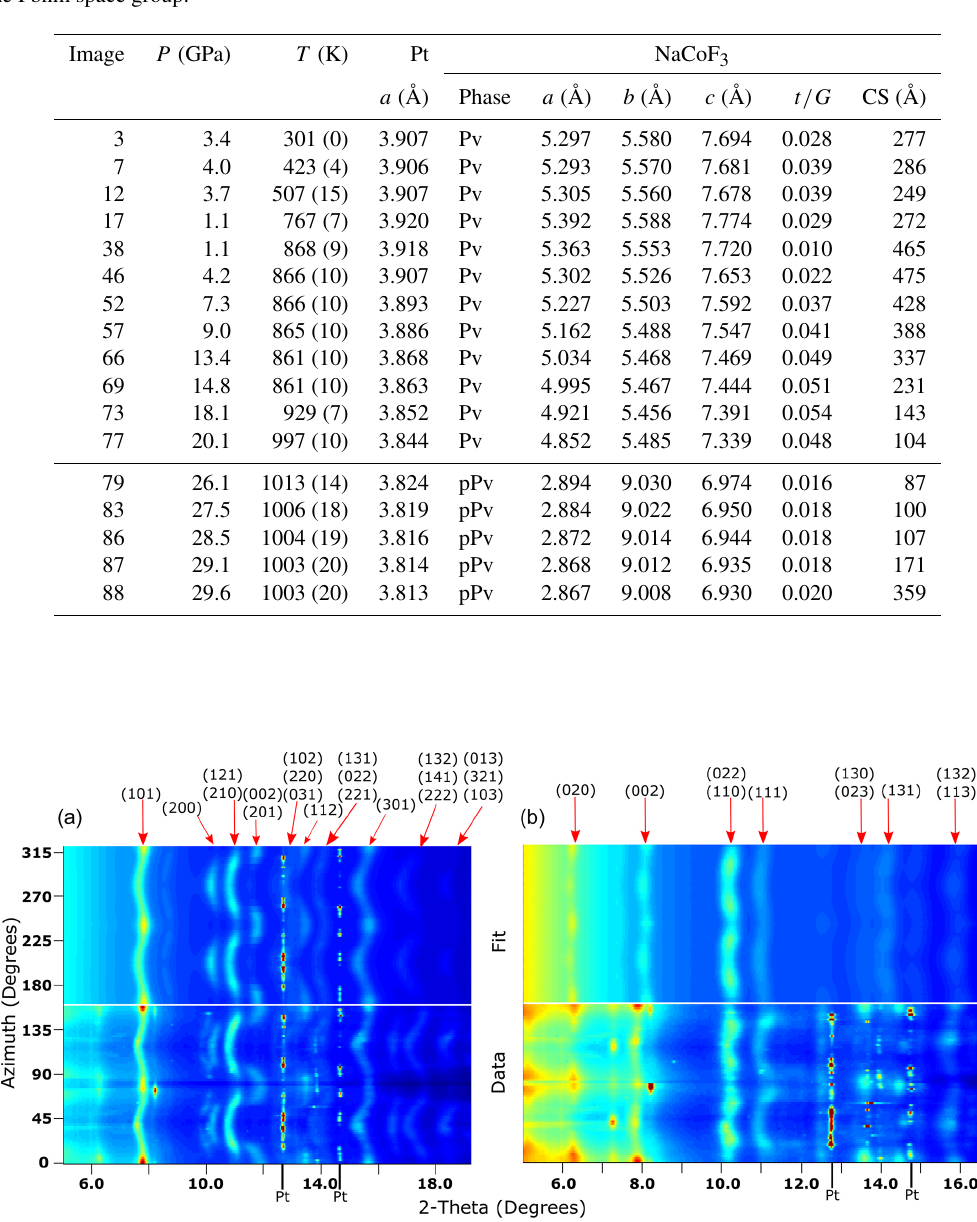
Figure 2. (a) Unrolled diffraction image of NaCoF 3 perovskite at 20.1GPa and 997K, immediately before transformation to post-perovskite. Below: measured diffraction (labeled data). Above: diffraction image recalculated by MAUD (labeled fit). Diffraction peaks of perovskite are labeled by their Miller indices, and platinum peaks are indicated by Pt. (b) Diffraction and fit for post-perovskite phase at 26.1GPa and 1013K. In both (a) and (b) diffraction lines vary in position and intensity, revealing texture and stress development due to compression. Graphite peaks from the heater are present at 6.0, 8.2, 13.4, and 14.6 ◦ 2 θ . These diffraction peaks, becoming more visible as the experiment proceeds, show no strain and were ignored if necessary during the refinement